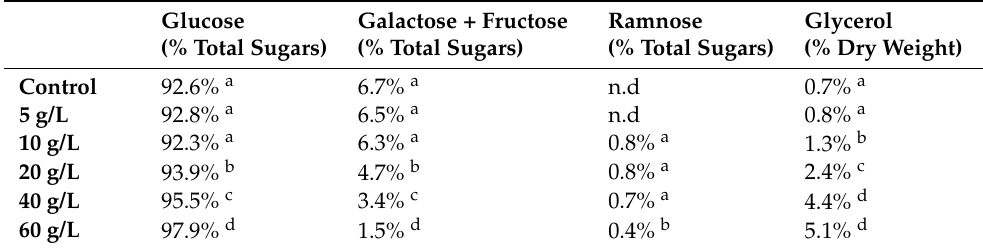
Table 2. Sugars and glycerol content of A. platensis grown at different salinities ( n = 3, ± SD). The different superscript letters denote statistically significant differences.